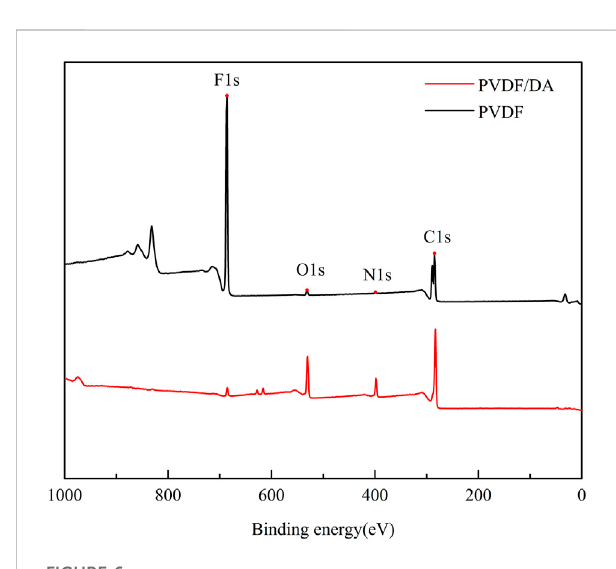
FIGURE 6 XPS full spectrum of PVDF and PVDF/DA